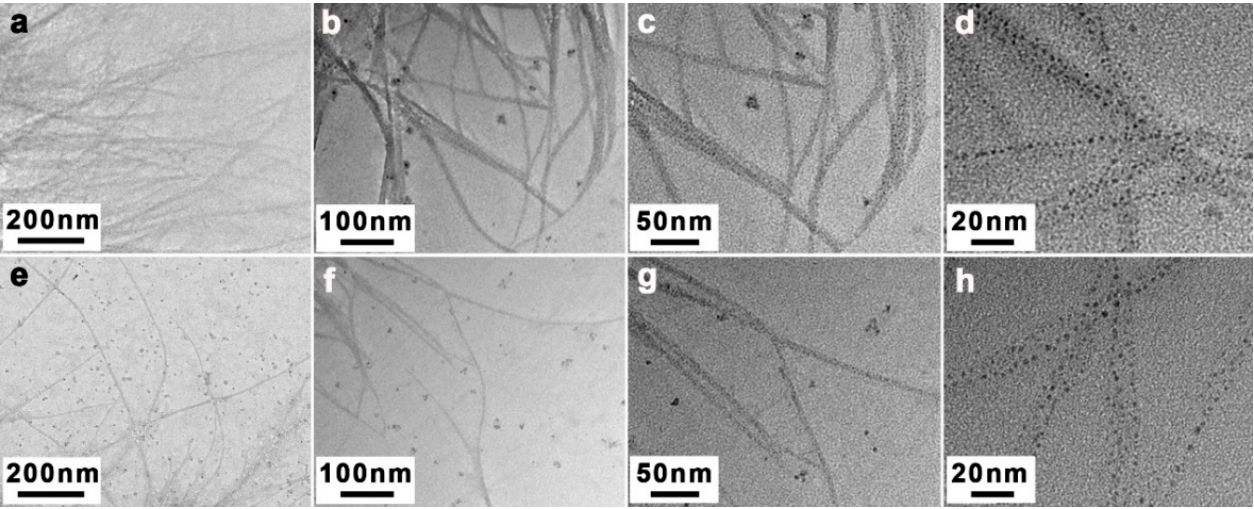
Figure 8. TEM images of CC in ( a – d ) 7 wt% NaOH and ( e – h ) 7 wt% NaOH/1.6 wt% ZnO aqueous solutions (c = 1.0 × 10 − 4 g/mL).